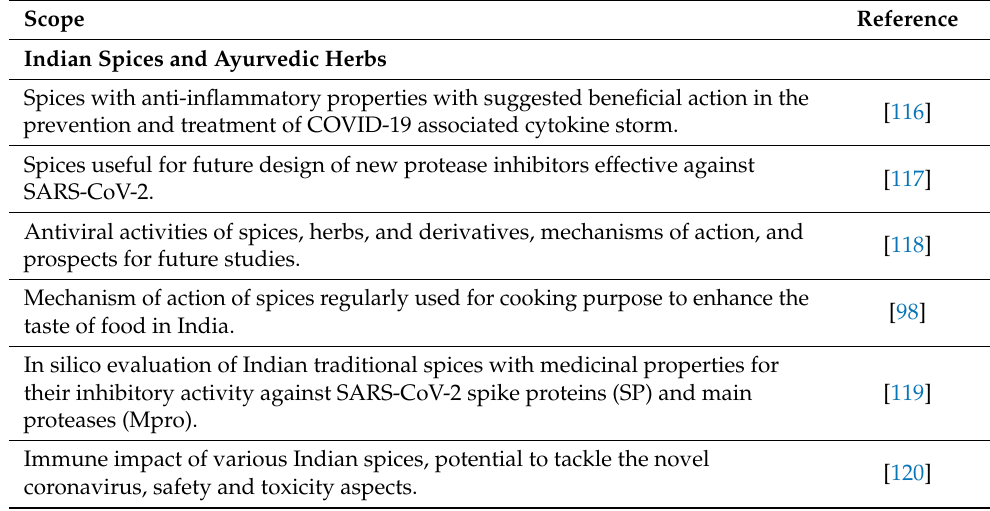
Table 4. Traditional plant species that are promising in the search for new antiviral